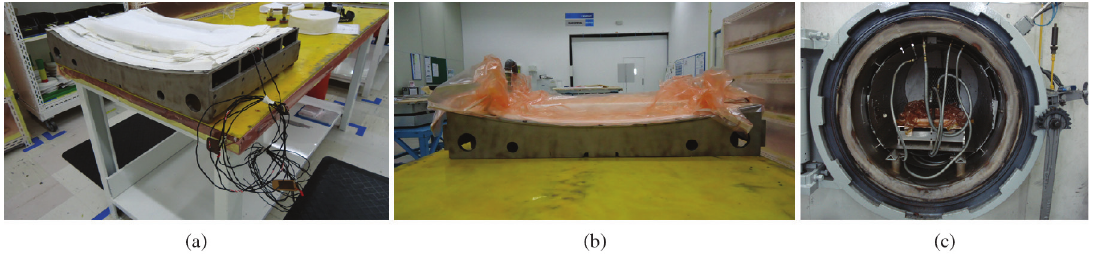
Figure 5. Sequence of CAF process: a) and b) vacuum bagging, c) autoclave loading.